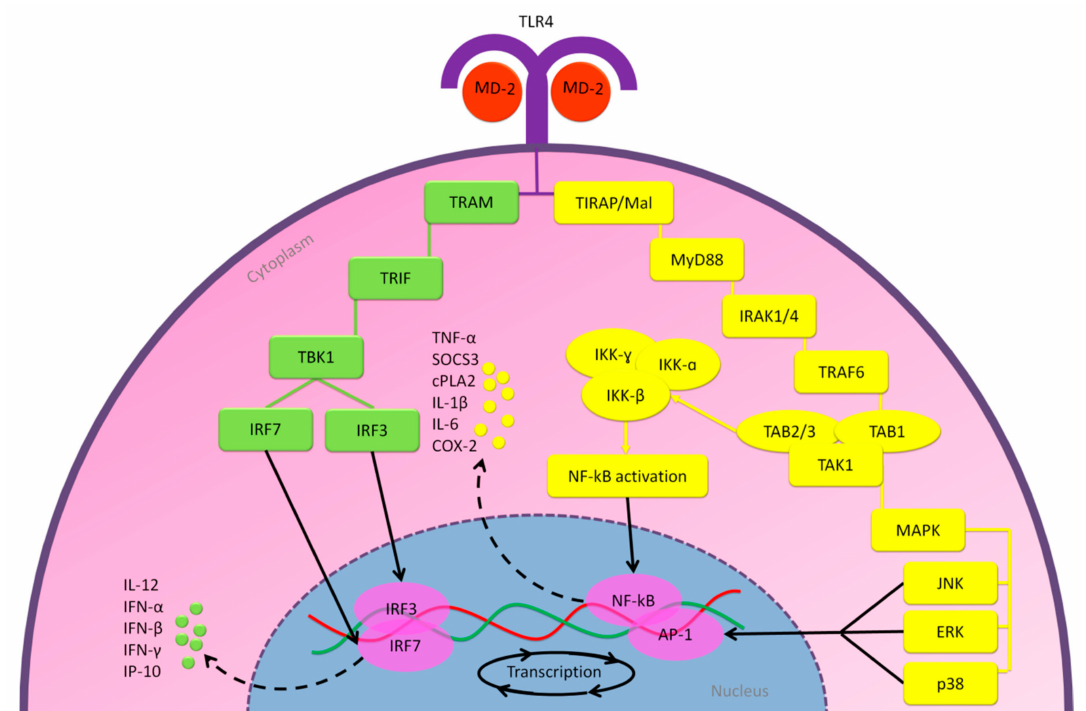
Figure 5. The signaling pathways of MD-2 / TLR4 axis that lead to stimulating the immune responses. Through binding to MD-2 hydrophobic pockets, viral proteins activate the MD-2 / TLR4 signaling axis. This interaction enables two cytoplasmic signaling domains; MyD88 via Toll–IL-1 receptor (TIR) domain-containing adaptor protein (TIRAP) / MyD88 adapter-like (Mal), and TIR domain-containing adaptor-inducing interferon- β (TRIF) via TRIF-related adaptor molecule (TRAM). The MyD88 / TIRAP pathway uses the members of IL-1 receptor-associated kinases 1 and 6 (IRAK1 / 4), TNF receptor-associated factor 6 (TRAF6), and transforming growth factor beta-activated kinase 1 (TAK1) complex to activate two transcription factors; nuclear factor kappa B (NF-kB), through the I kappa B kinase (IKK) complex, and activator protein-1 (AP-1), through the mitogen-activated protein kinases (MAPK). Both NF-kB and AP-1 regulates gene expression in response to pathogen infections and controls cytokines expression. On the other side, the TRIF / TRAM pathway activates the transcription factor interferon regulatory factor 3 (IRF3) and IRF7, through TANK binding kinase 1 (TBK1), that is involved in the regulation of innate immune responses [80–82]. JNK, c-jun n-terminal kinase; ERK, extracellular signal-regulated